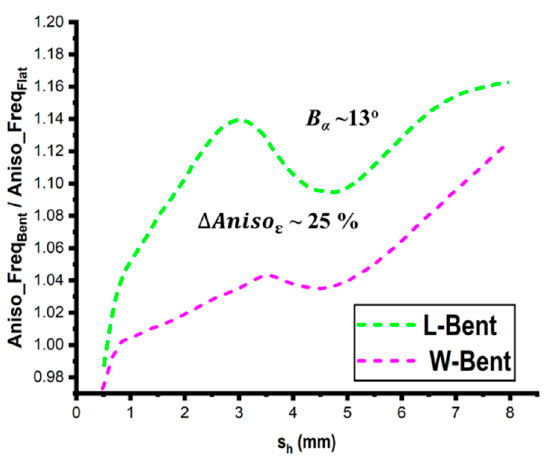
Figure 12. Bending e ff ect on an anisotropic substrate with respect to the substrate height ( s h ).